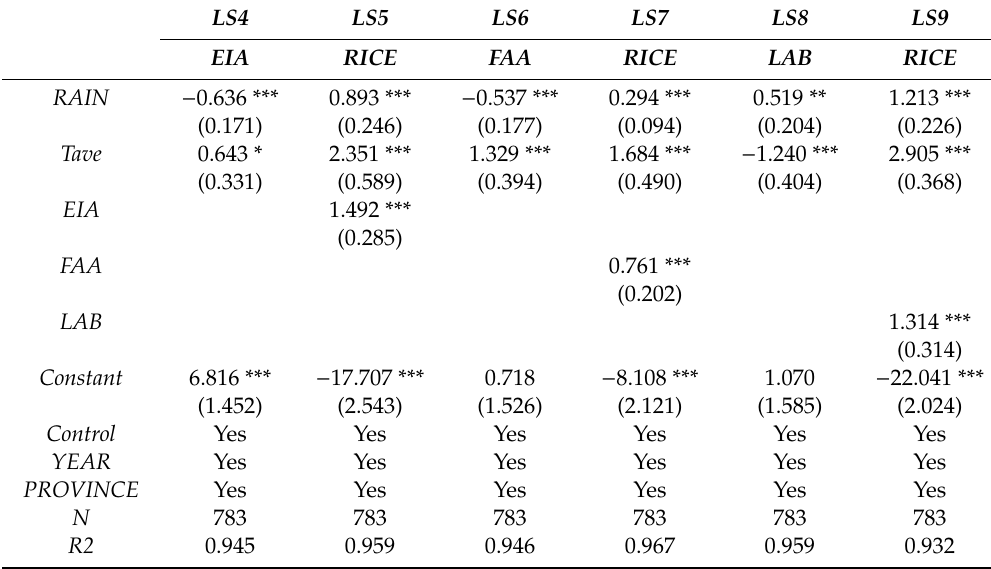
Table 3. The regression results of the mediating e ff ect of climate